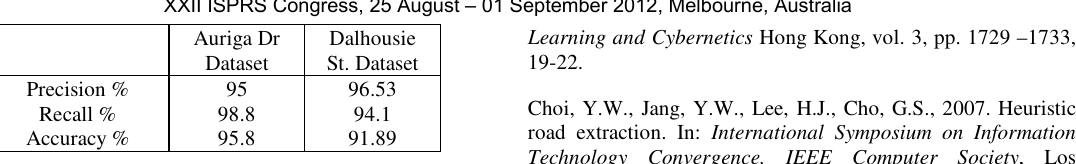
Table 2. Evaluation of the extracted street floor for Auriga Dr. and Dalhousie St